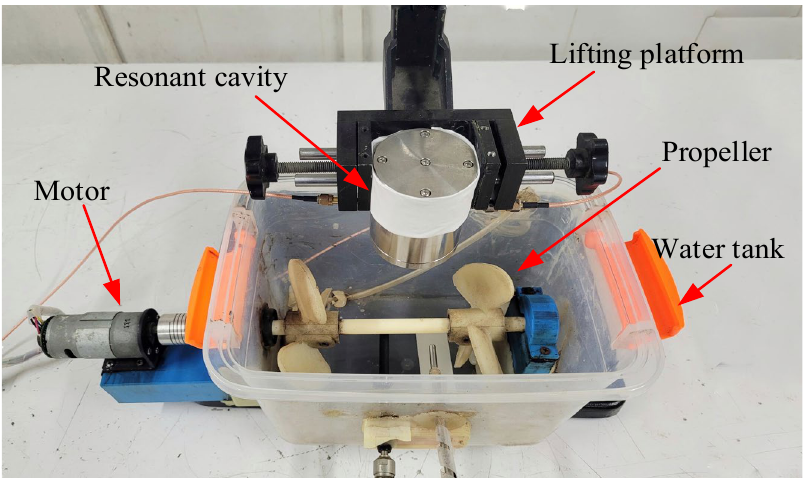
Figure 13. Online measurement platform for syrup brix.